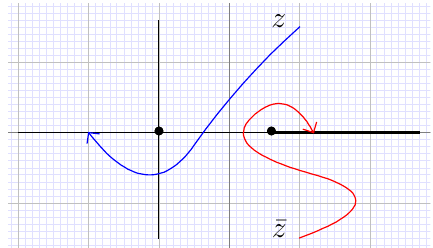
Figure 13 . z, z curves for computing the hO 1 O 3 O 2 O 4 i ordering via